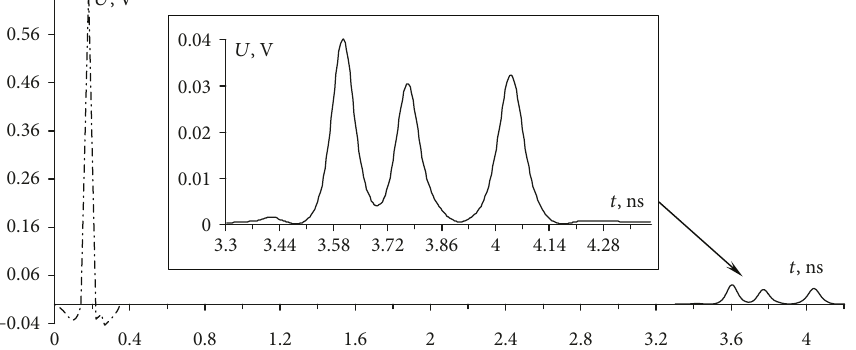
Figure 5: Voltage waveforms at the input ( – · – ) and output ( — ) (with enlarged fragment of the signal at the output) of a three-conductor microstrip line MF with the parameters obtained as a result of heuristic search.